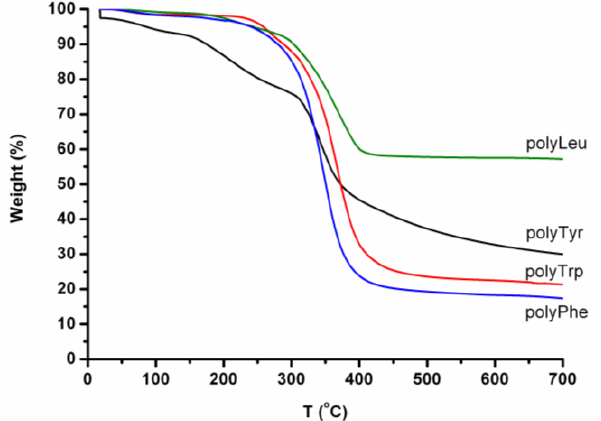
Figure 32. TGA curves of oligoLeu, oligoTyr, oligoTrp and